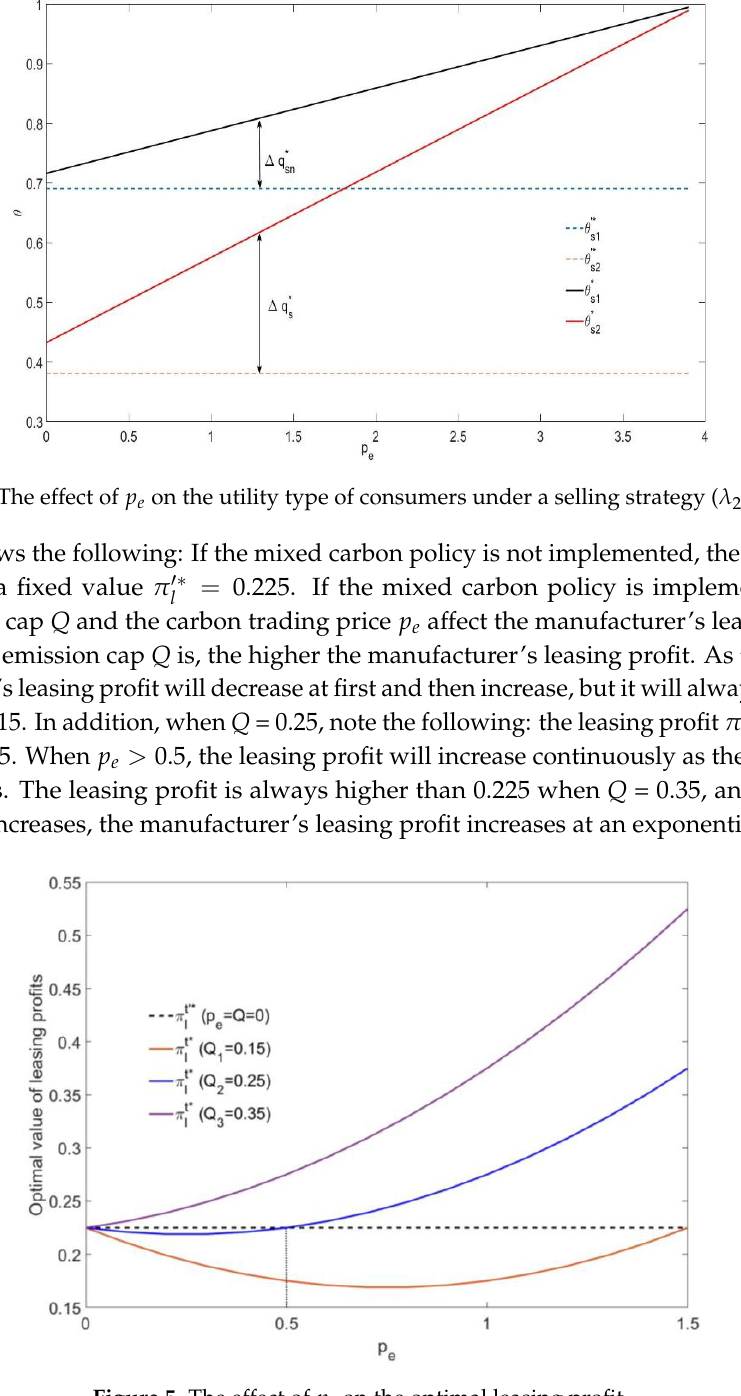
Figure 6. The effect of e p on the optimal selling profit ( 2